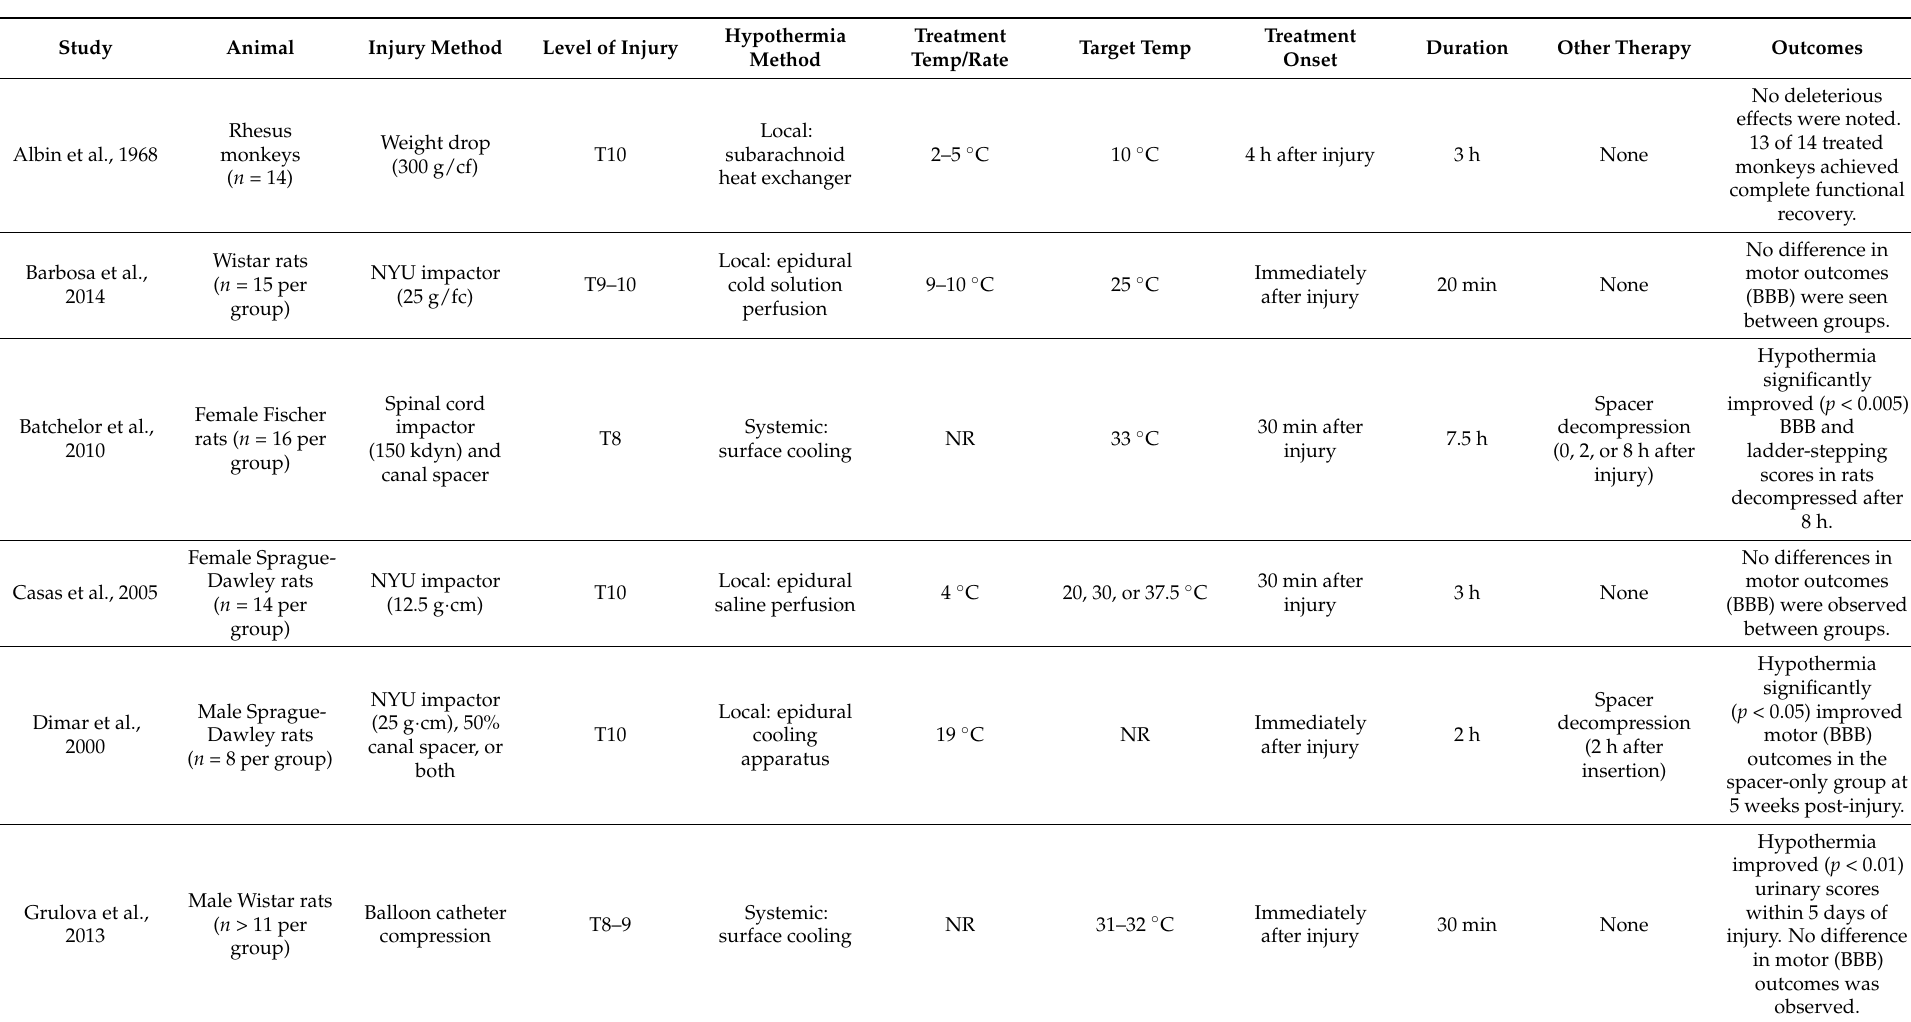
Table 1. Data overview of 24 animal studies utilizing hypothermia as therapy after TSCI [5,22–36,38–42]. NR = not reported; BBB = Basso–Beattie–Bresnahan locomotor rating